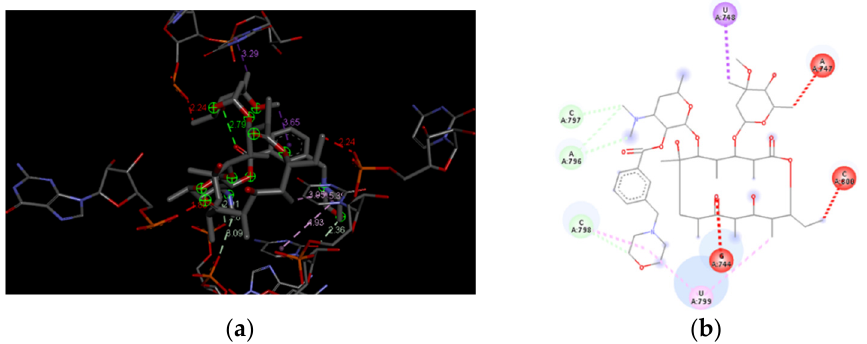
Figure 4. ( a ) Graphical representation of the obtained interactions between erythromycin B 2 ′ -[3- (morpholinomethyl)benzoate] and the segment of the exit tunnel from apicoplast ribosome of P. falciparum with distances in Å; ( b ) 2D diagram of receptor–ligand interactions.